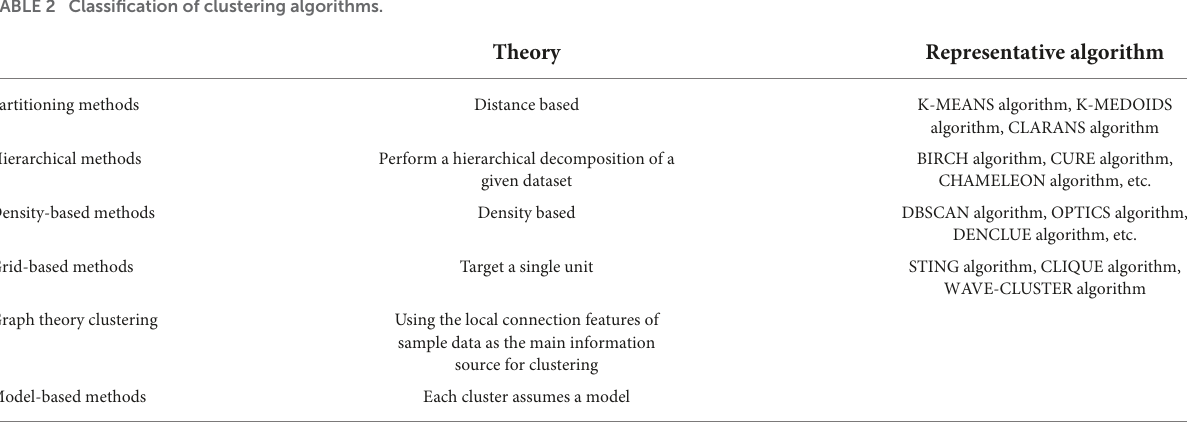
TABLE 2 Classification of clustering